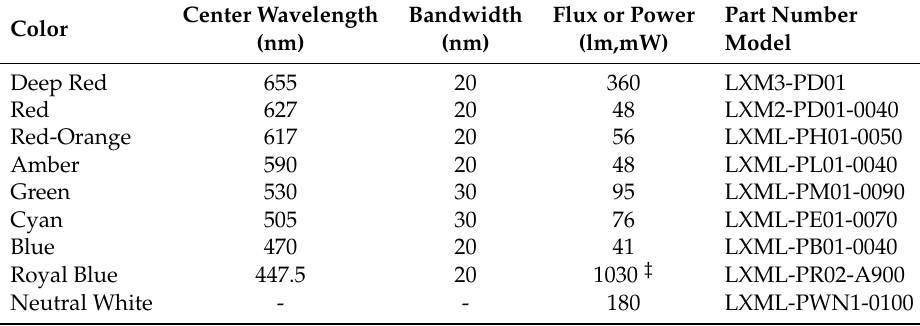
Table 1. Specifications of Luxeon Rebel series LEDs at 350